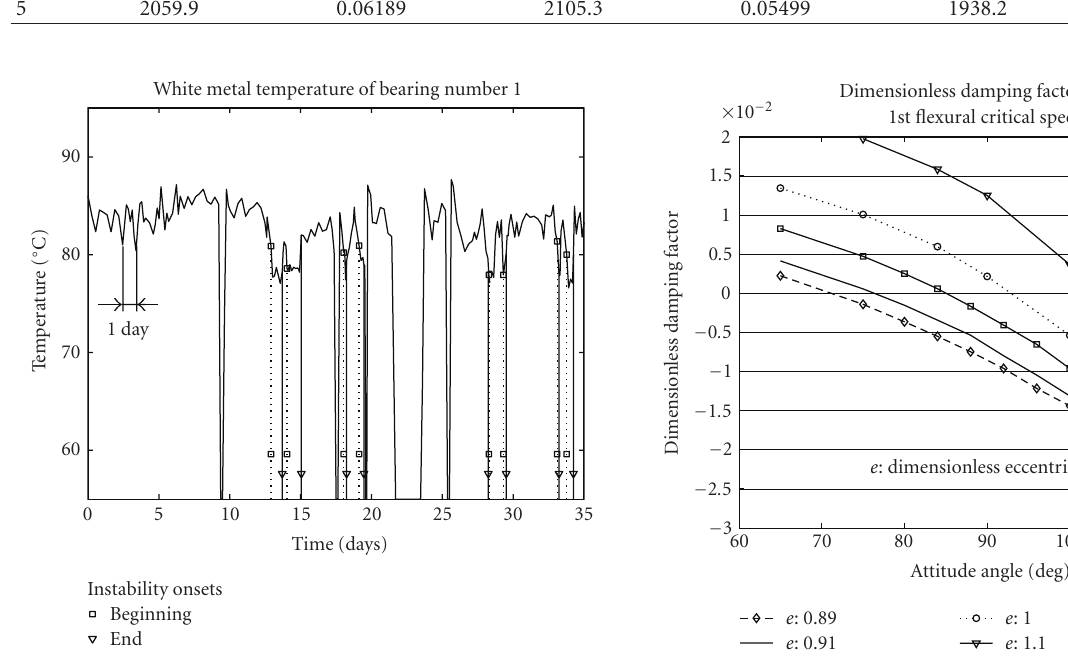
Figure 14: Historic trend of the temperature of the lower lobe of bearing no. 1 measured during a 35 days’ period. Figure 15: Influence of attitude angle and journal eccentricity ratio in bearing no. 1 on the dimensionless damping factor associated with the 1st flexural critical